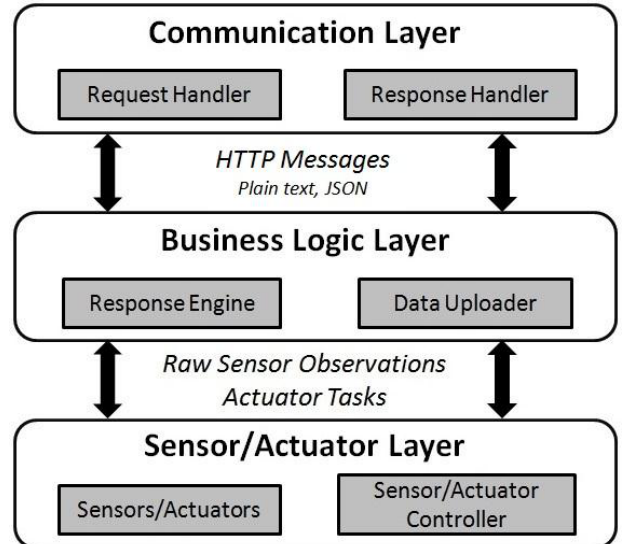
Figure 10. The device architecture supporting the OGC SensorThings